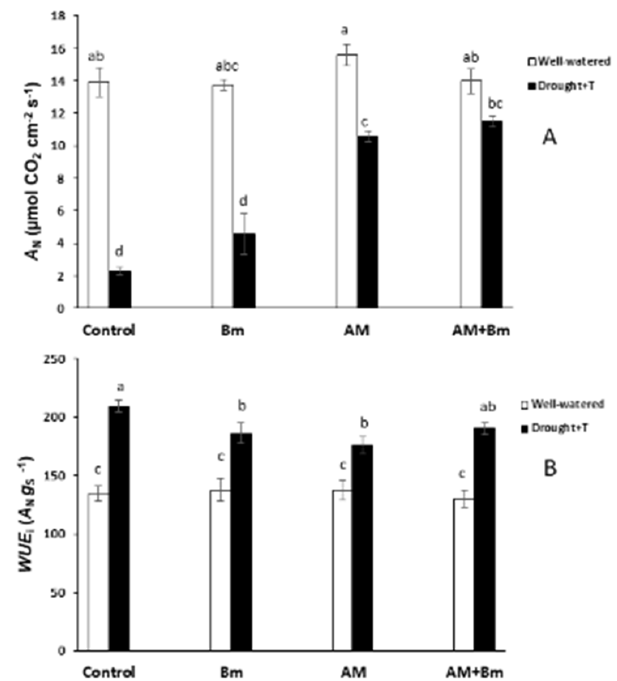
Figure 4. ( A ) Net photosynthetic activity (An) and ( B ) instantaneous water-use efficiency (WUEi) in maize plants inoculated or not (control) with a PGPR strain of Bacillus megaterium (Bm), with the arbuscular mycorrhizal fungus Rhizophagus irregularis (AM) or with both microorganisms (AM + Bm). Plants were cultivated under standard ambient temperature and well-watering conditions (well-watered) or subjected to a combined drought and high temperature stress (drought + T) for 15 days before harvest. Data represent the means (n = 8) ± S.E. Different letters indicate significant differences between treatments ( p < 0.05) based on the Tukey–Kramer test.